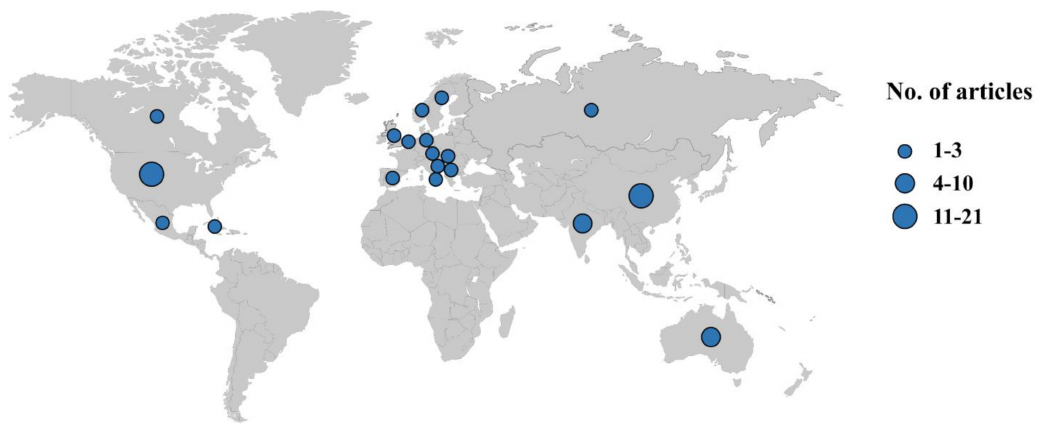
Figure 5. The global spatial distribution of the collected data. China and the United States are the main countries in this study, followed by India.